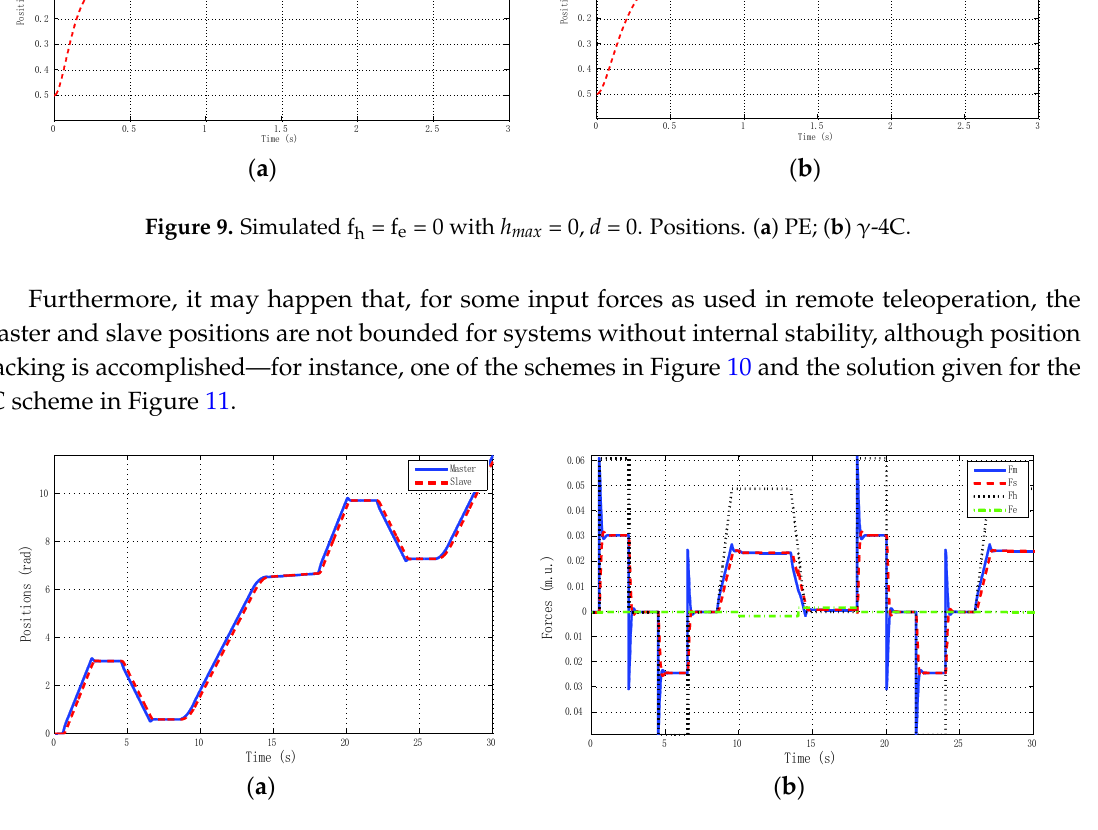
Figure 10. Simulated ramp-step reference force: PE control scheme with h max = 0, d = 0. ( a ) Positions; ( b ) Forces.